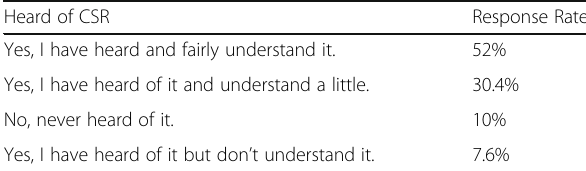
Table 1 Awareness CSR Heard of CSR Response